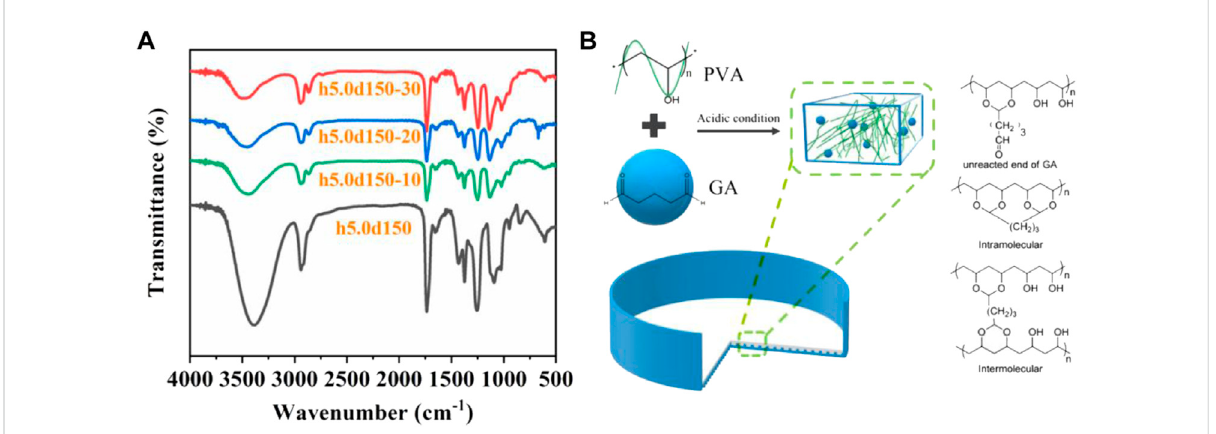
FIGURE 3 (A) FTIRspectraofh5.0d15, h5.0d15-10,h5.0d15-20 and h5.0d15-30; (B) Mechanismdiagramoftheacetalizedcross-linking reaction between hydroxyl group of PVA and